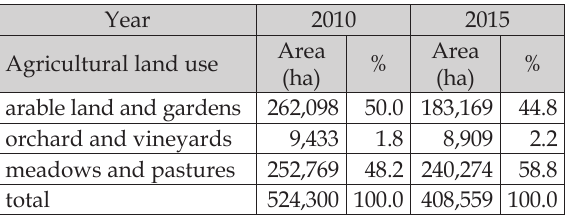
Table 2. The structure of agricultural land by usage